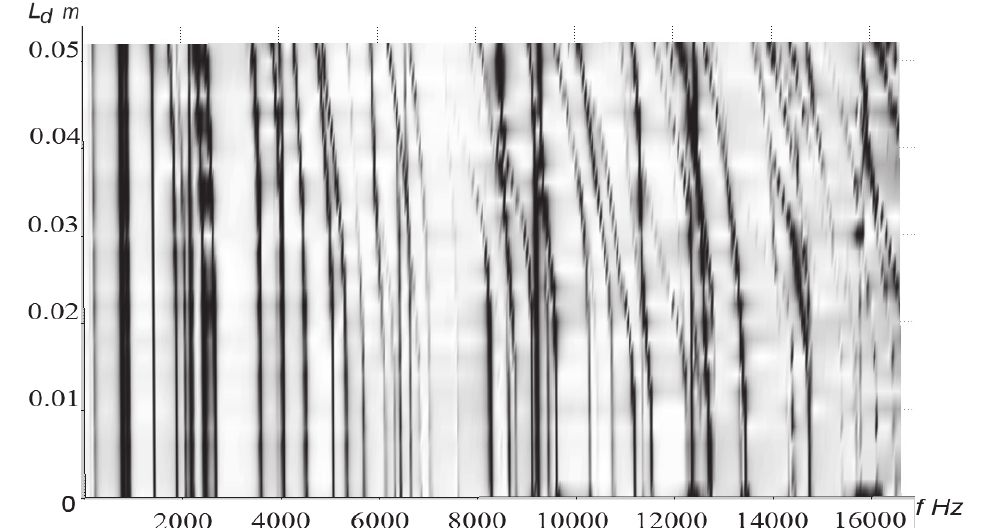
Figure 7: Shifts of natural frequencies in the contact model of